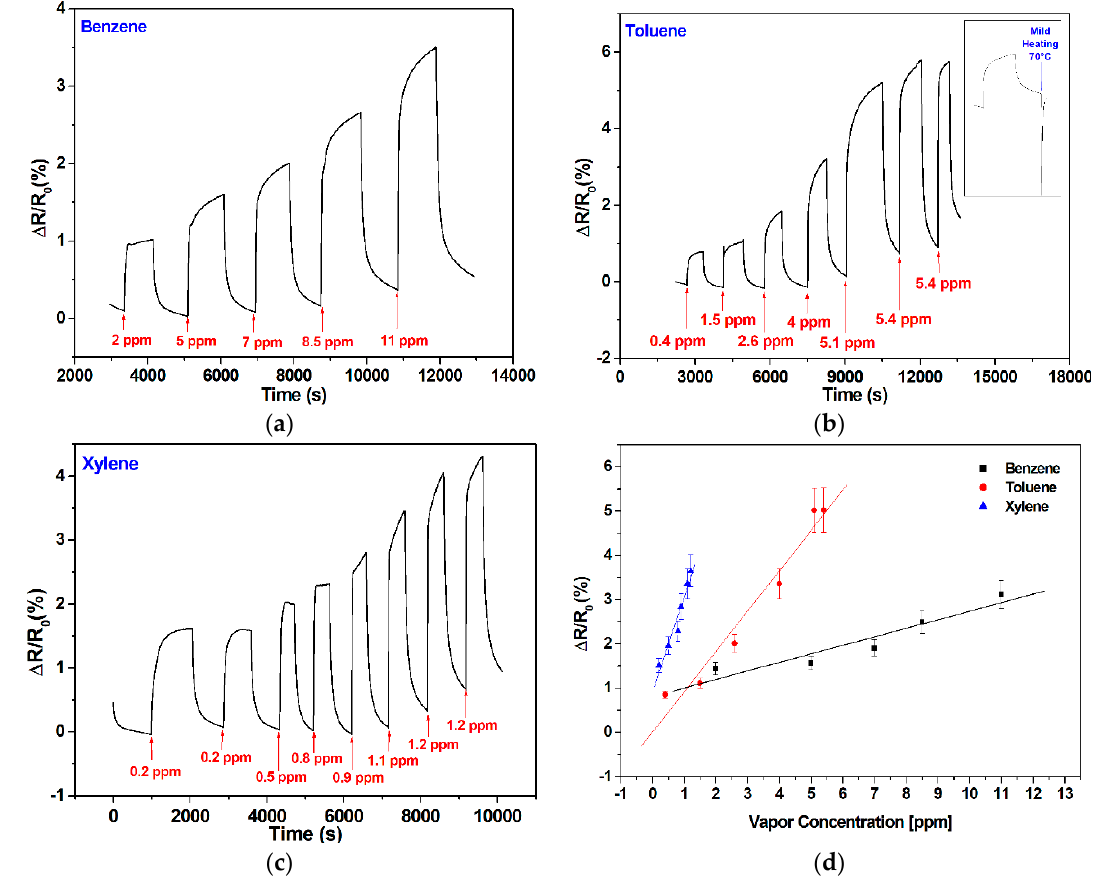
Figure 4. Graphene sensor responses for di ff erent concentrations of injected vapors of ( a ) benzene; ( b ) toluene; ( c ) xylene; and ( d ) associated calibration curves. The inset in panel b shows how applying mild heating helps regenerating sensor surface and fully recovering its baseline.